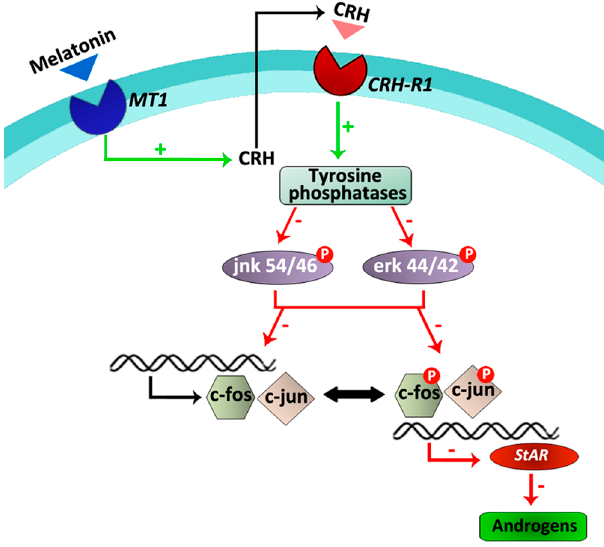
Figure 2. Schematic overview of the melatonin/CRH signaling pathway in hamster Leydig cells. Melatonin locally stimulates CRH production in hamster Leydig cells. Thus, activation of tyrosine phosphatases via Crh-r1 receptors leads to reduced phosphorylation levels of erk 44/42 and jnk 54/46, down-regulation of c-jun and c-fos expression, inhibition of the transcription factors phosphorylation, decreased expression of StAR and consequently, diminished androgen production [12,54]. Green arrows/+ symbolize stimulatory effects. Red arrows/- symbolize inhibitory effects. Taken together, the present results indicate that, at least in hamster Leydig cells, melatonin inhibits androgen production via its interaction with the local CRH system and a regulatory pathway composed of tyrosine phosphatases, MAP kinases and transcription factors.